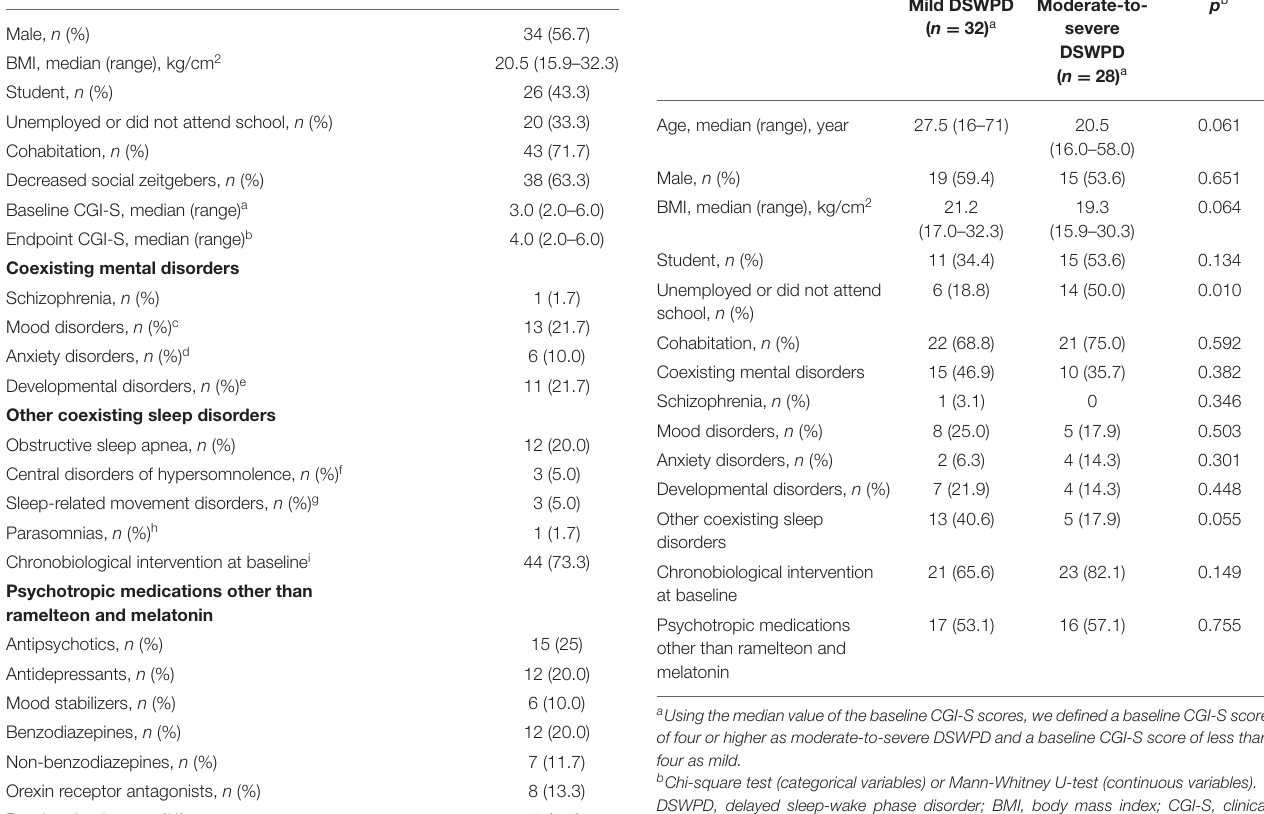
TABLE 2 | Characteristics of patients before the pandemic: mild vs. moderate-to-severe DSWPD. Mild DSWPD Moderate-to- ( n = 32) a